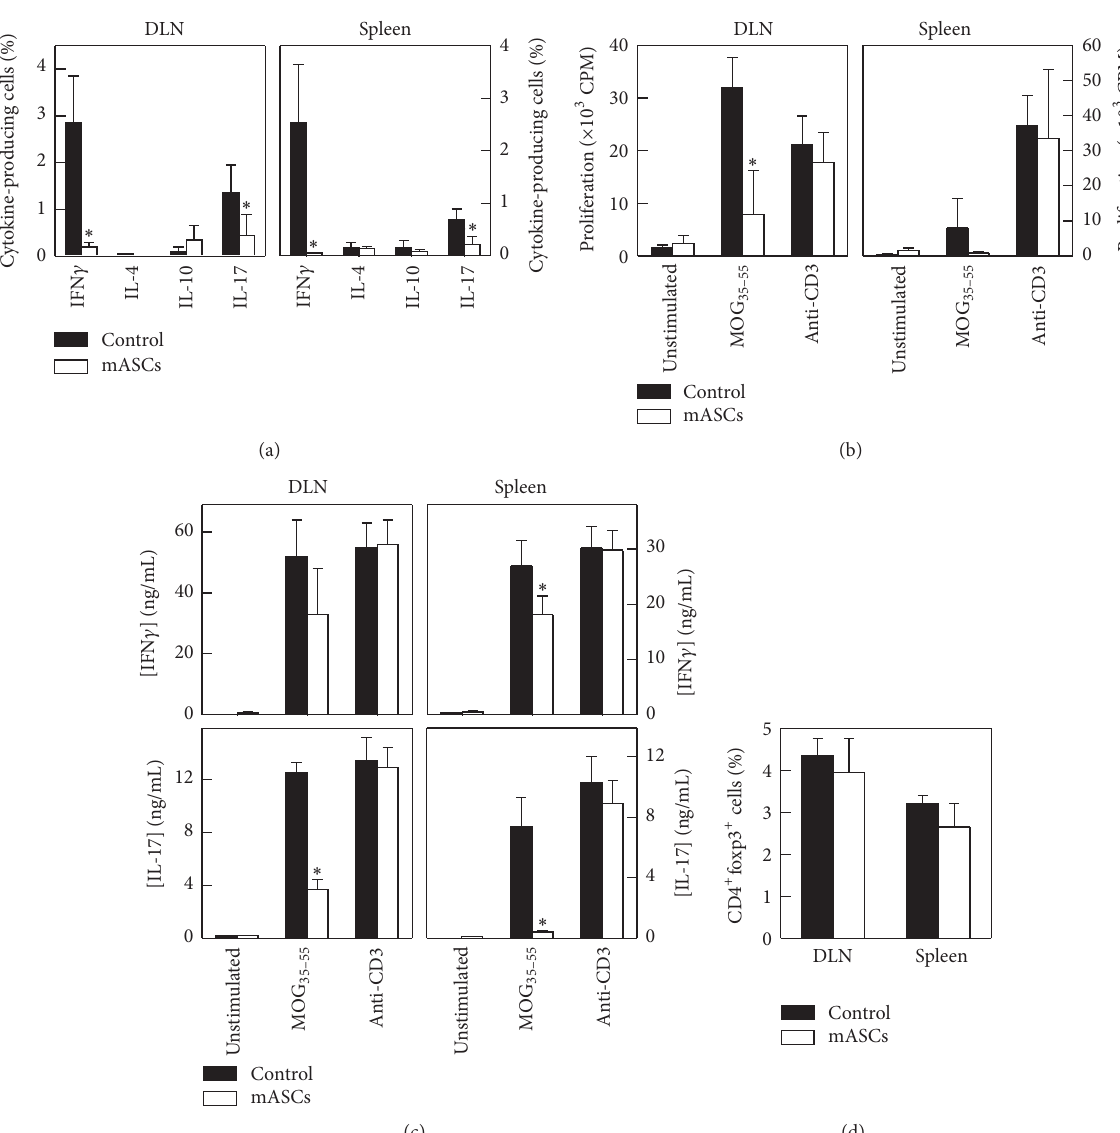
Figure4:AllogeneicmASCsinhibitMOG-specificimmuneresponsesbutdonotinducefoxp3 + Tregs.mASCswereinjectedintraperitoneally in MOG-induced EAE mice after the onset of the clinical symptoms and spleens and DLNs were isolated at the peak of the disease. Untreated EAE mice were used as controls. (a) The percentages of cytokine-producing cells in spleen and DLNs were determined by intracellular flow cytometryasdescribedinMaterialsandMethods.((b)and(c))DLNandspleencellswereculturedwithmedium(unstimulated)orstimulated with MOG 35−55 (50 𝜇 g/mL) or anti-CD3 (1 𝜇 g/mL, used as unspecific stimulation). Proliferation was measured after 3 days by [ 3 H]-thymidine incorporation (b). The content of cytokines was determined in culture supernatants after 48 hours (c). (d) The percentages of CD4 + Foxp3 + T cells in spleen and DLNs were determined by flow cytometry. Results are shown as mean (SD) from 4 mice per group. ∗ 𝑝 < 0.05 versus